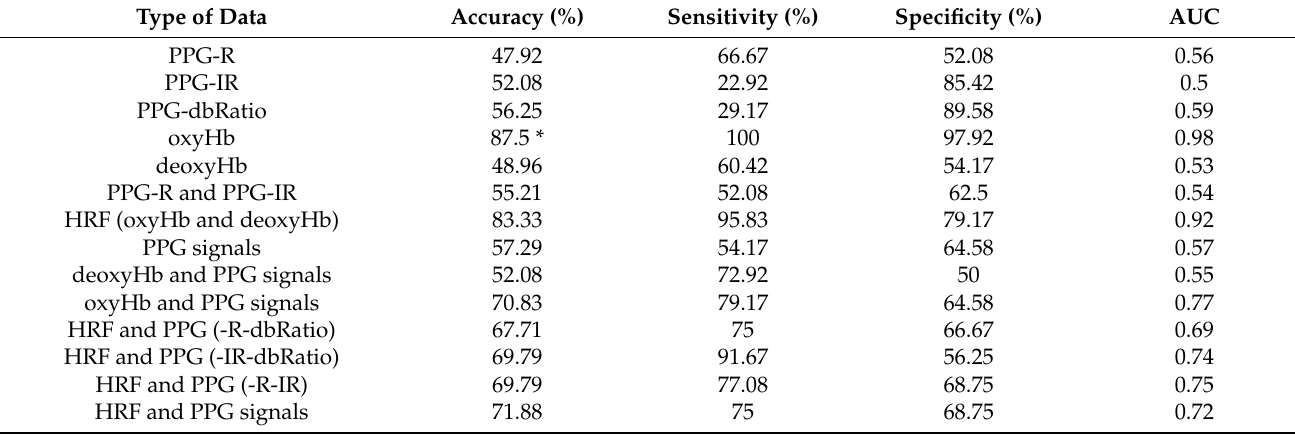
Table 2. Support vector machines with quadratic kernel function; all signals were photoplethysmography signals (PPG-R, PPG-IR, and PPG-dbRatio) and hemodynamic response function signals (oxyHb and deoxyHb). The superscript asterisk is the best accuracy in table.